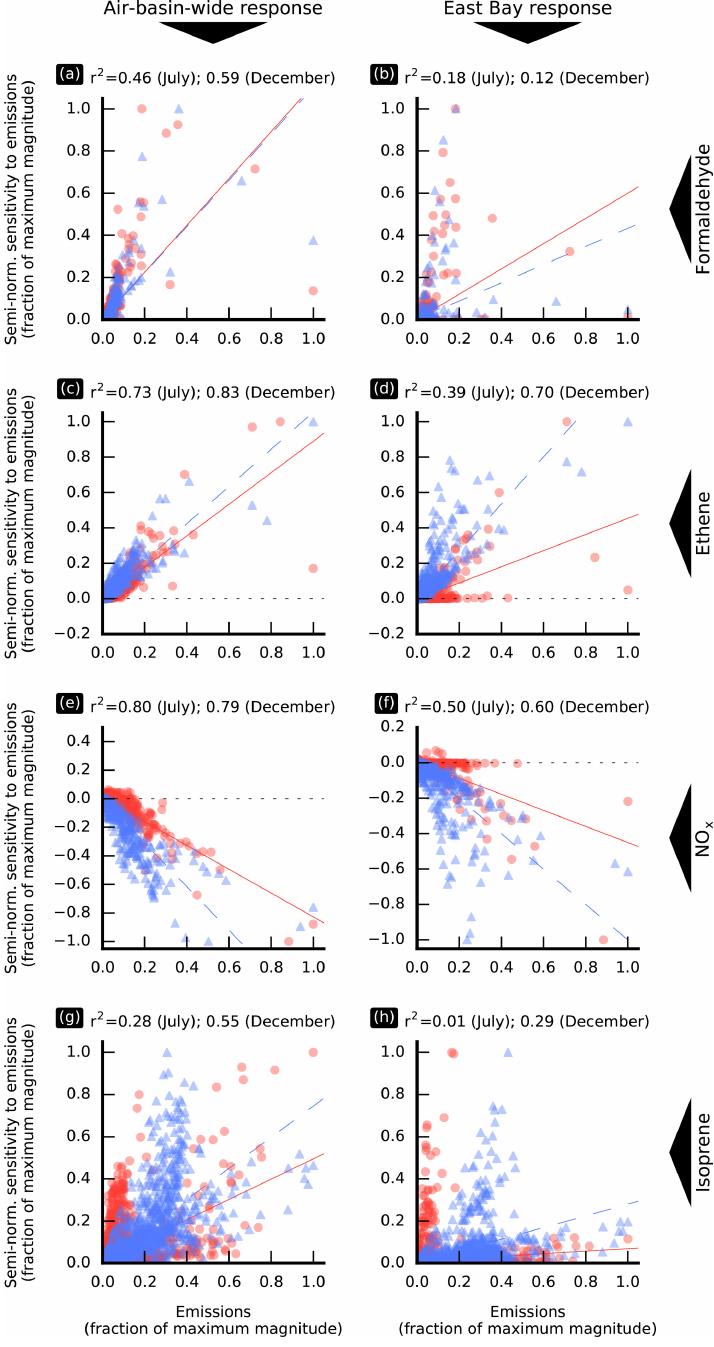
Figure 5. Semi-normalized sensitivity of model responses to individual emission sources versus the magnitude of these sources. Values are shown separately for the July (red circles) and December (blue triangles) simulation periods along with the corresponding linear regression affine lines (solid red line for July and dashed blue line for December). The corresponding coefficients of determination, r 2 , are indicated on the top of each subplot. In this figure, an “individual emission source” corresponds to emissions of a model species in a single model grid cell. Values are averaged over the simulation